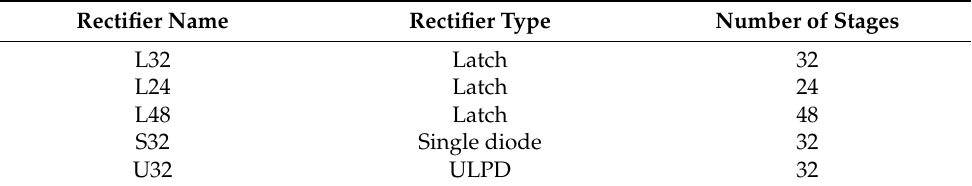
Table 3. Fabricated rectifiers.